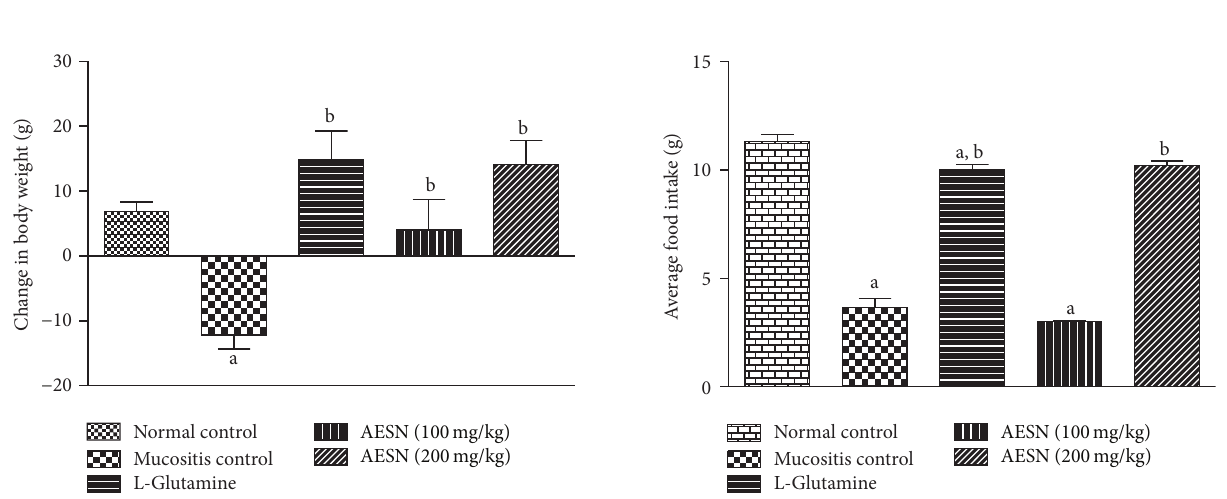
Figure 7: Body weight change in methotrexate induced oral mucositis. Body weight change in each group was recorded from day 1 to day 15. All values are expressed as mean ± SEM of 6 animals. a 𝑃 < 0.05 versus normal control, b 𝑃 < 0.05 versus mucositis control.